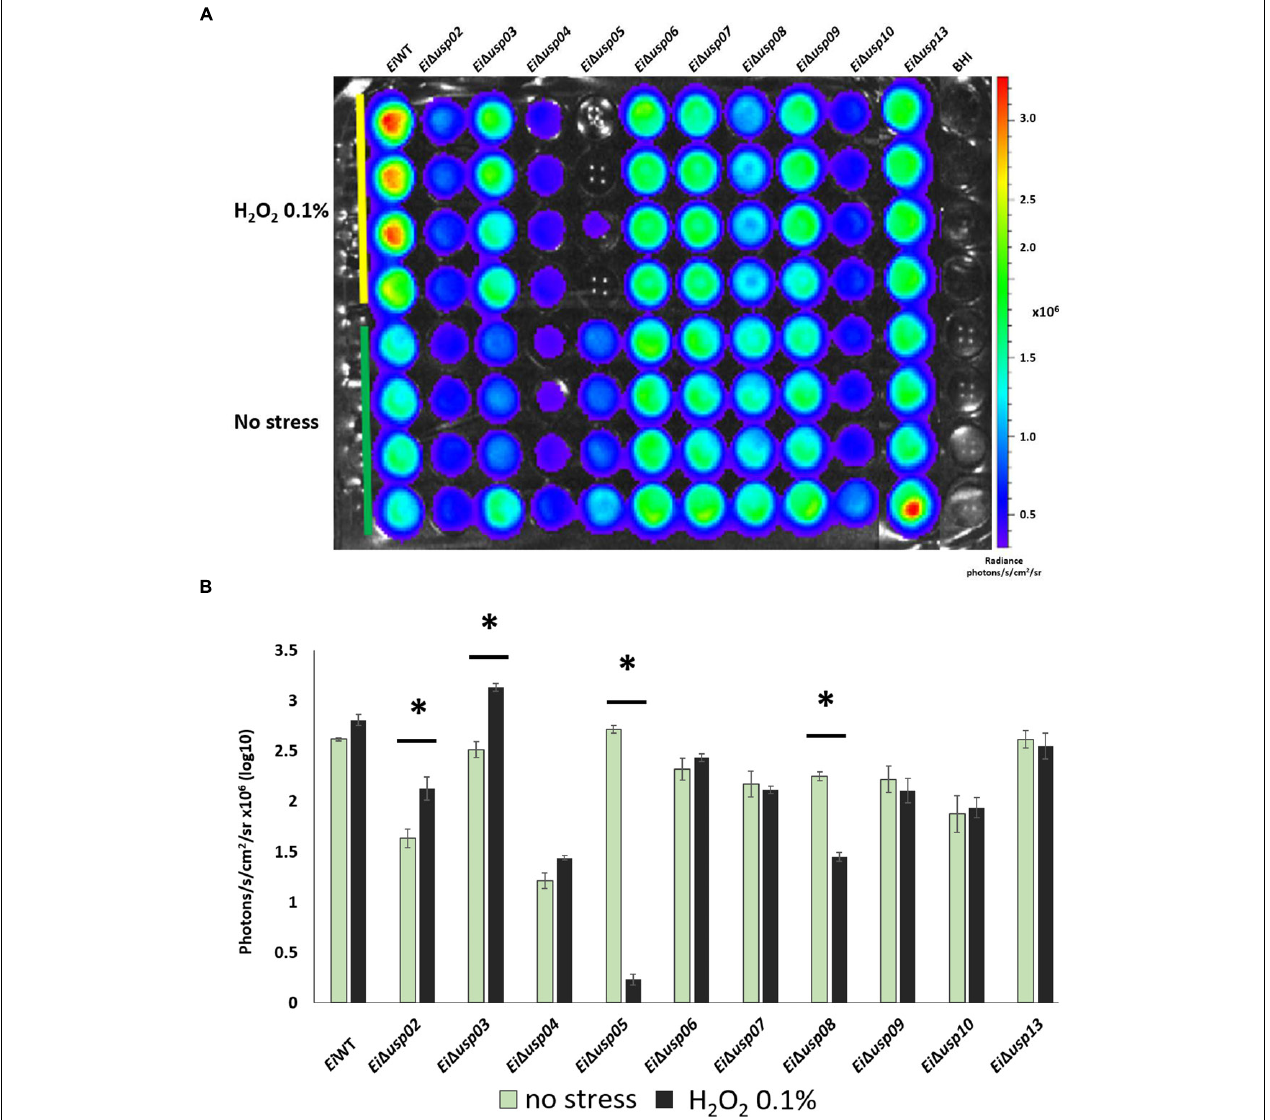
FIGURE 5 | The survival assay of E. ictaluri WT and USP mutants exposed to 0.1% H 2 O 2 . (A) Each strain had four replicates (column A–D). Strains start with E. ictaluri WT , Ei (cid:49) usp02-13 and BHI control. (B) The bars show the difference between bioluminescence of USP mutants and WT. ∗ indicates a significant difference between stress and non-stress at P <